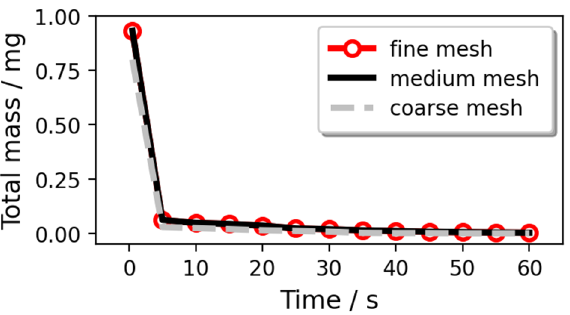
Figure 5. Variation in the total mass of coughing droplets varying the mesh